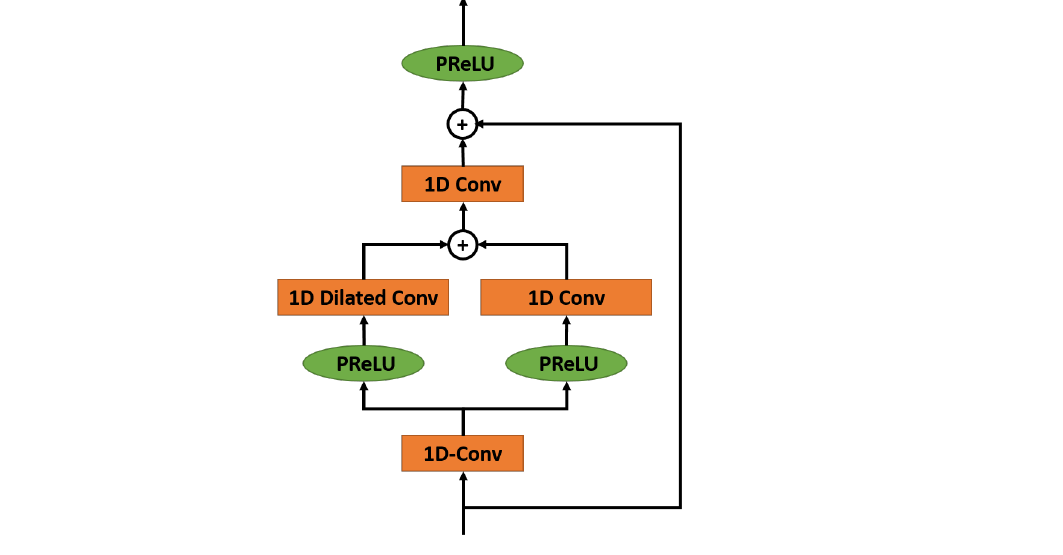
Figure 2. Hybrid dilated and conventional convolution